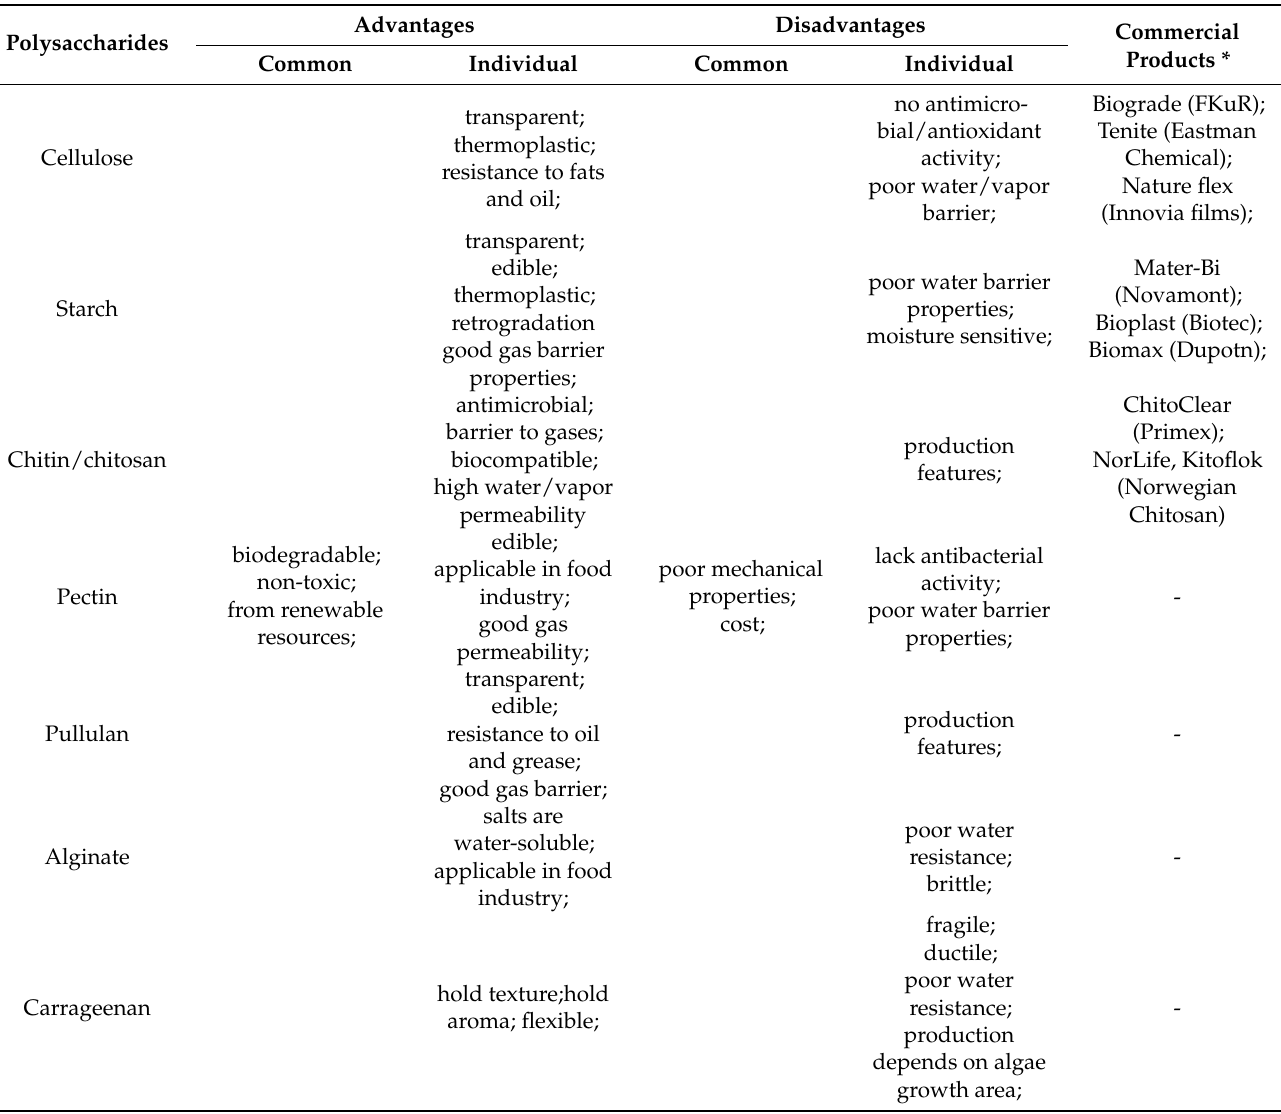
Table 1. Advantages/disadvantages of polysaccharides as component of biodegradable material.